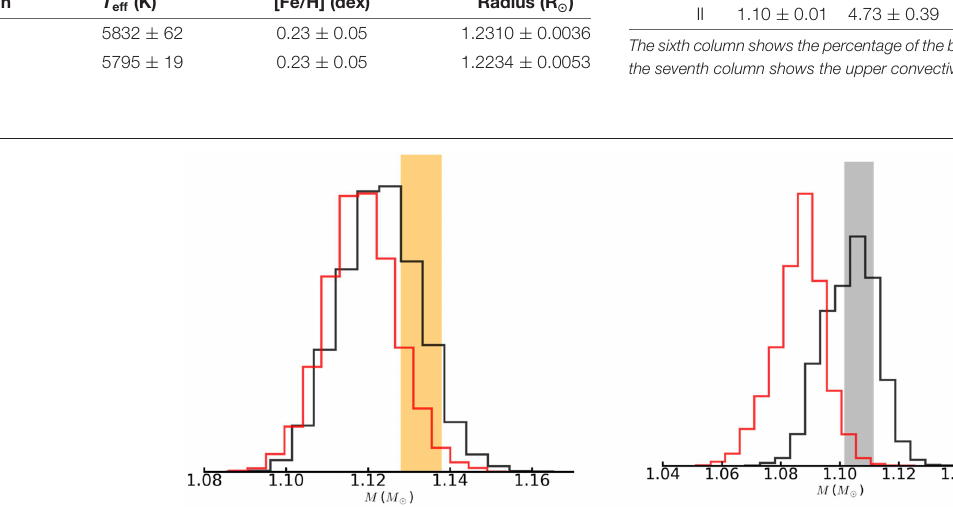
Frontiers in Astronomy and Space Sciences |